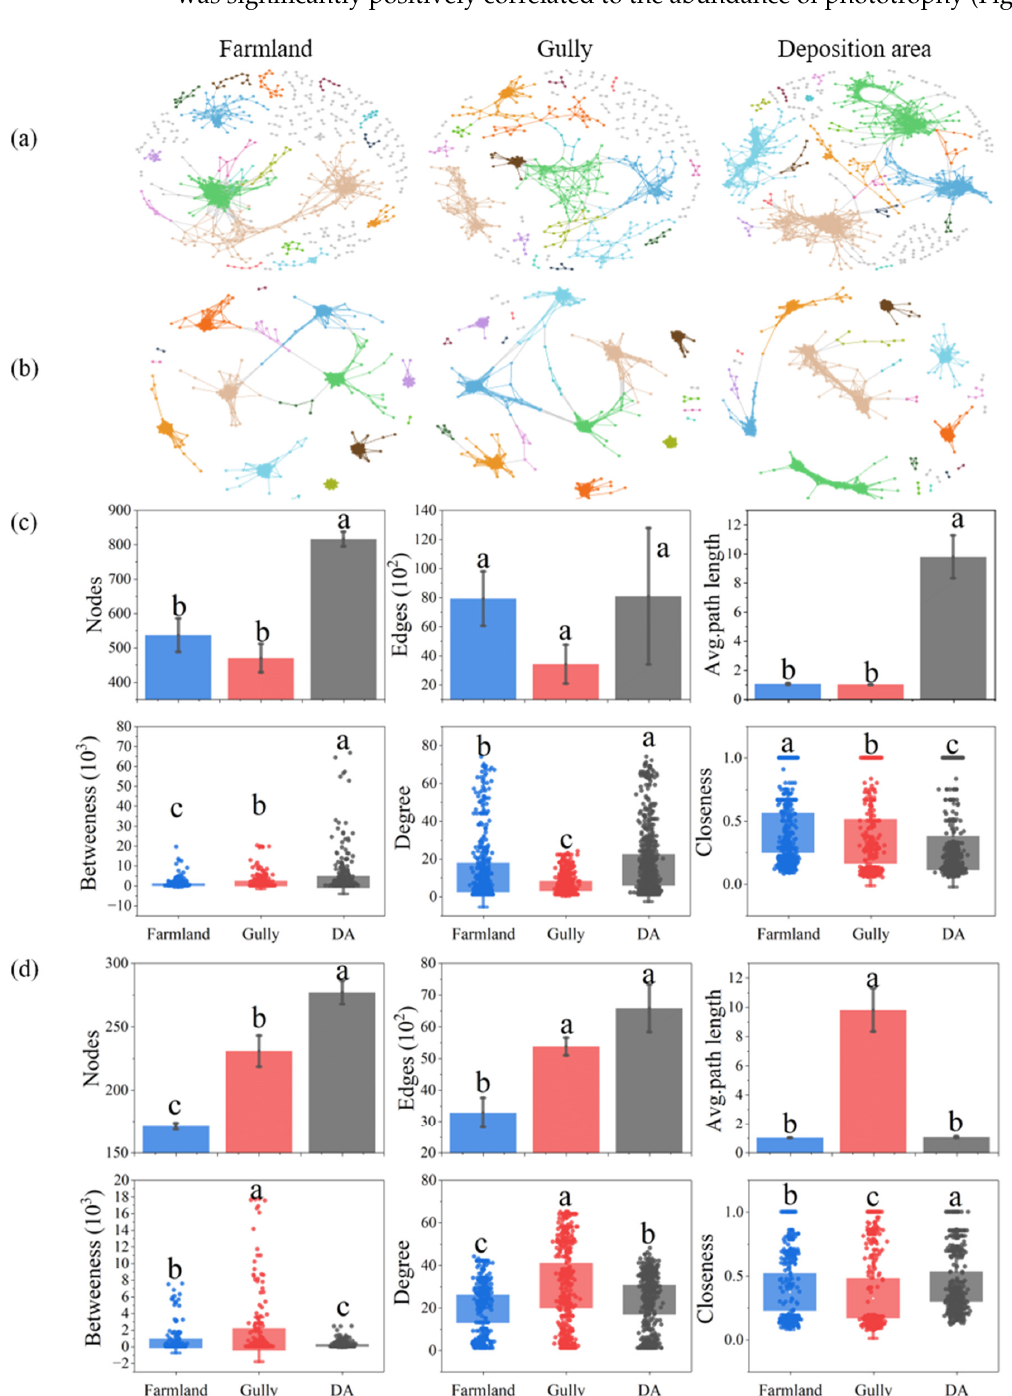
Figure 5. The difference in co-occurrence patterns of soil bacterial and fungal are among farmland, gully, and deposition area (DA) in 0–60 cm soil depth. ( a , b ) are co-occurrence networks of soil bacteria and fungi. The nodes in the network are colored by modularity class. The numbers of nodes, edges and three centrality indexes (betweenness, degree and closeness) represent the soil bacterial ( c ) and fungal ( d ) co-occurrence patterns from farmland to gully to deposition area. Error bars are double the standard error of the mean. Mean values with the same lowercase are not significantly different at p < 0.05 among farmland, gully, and deposition area.